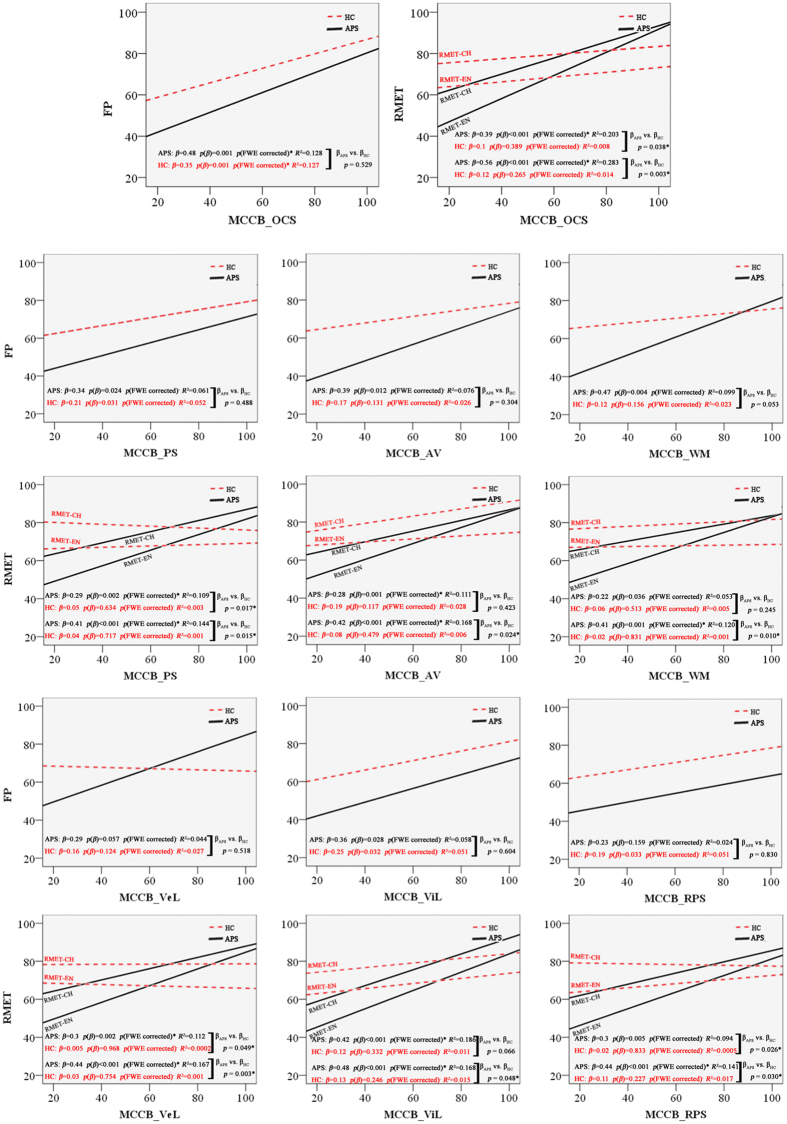
Correlations between FP and RMET performance and MCCB scores in APS (solid line) and HC (dashed line) subjects.